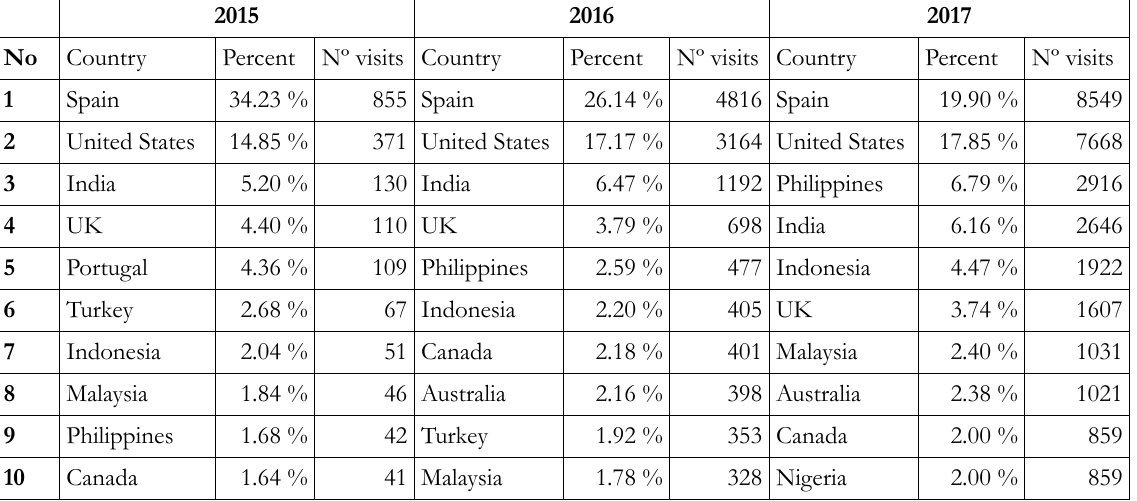
Table 3. JOTSE's visits from 4th November 2015 to 10th January